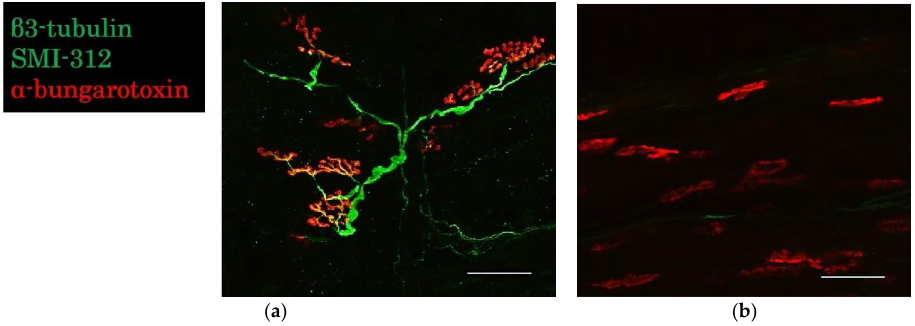
Figure 5. Evaluation of the neuromuscular junction after immunohistochemistry. ( a ) Microscopic image of extensor hallucis longus in the E 27 group. ( b ) Microscopic image of extensor hallucis longus in the surgical control group. Scale bar = 50 µm.